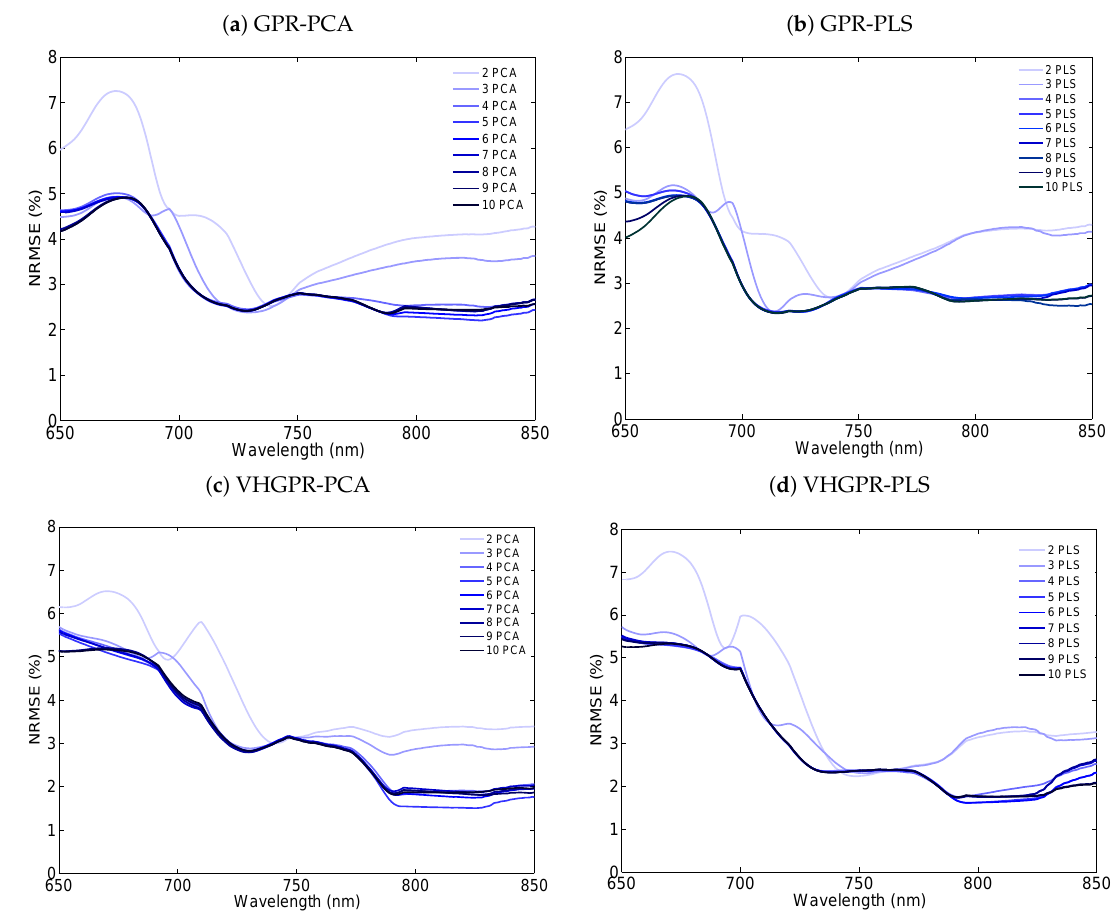
Figure 7. SCOPE NRMSE [%] results for the validation for 30% of 500 SCOPE SIF spectra using 2–10 ( a ) GPR-PCA, ( b ) GPR-PLS, ( c ) VHGPR-PCA and ( d ) VHGPR-PLS components